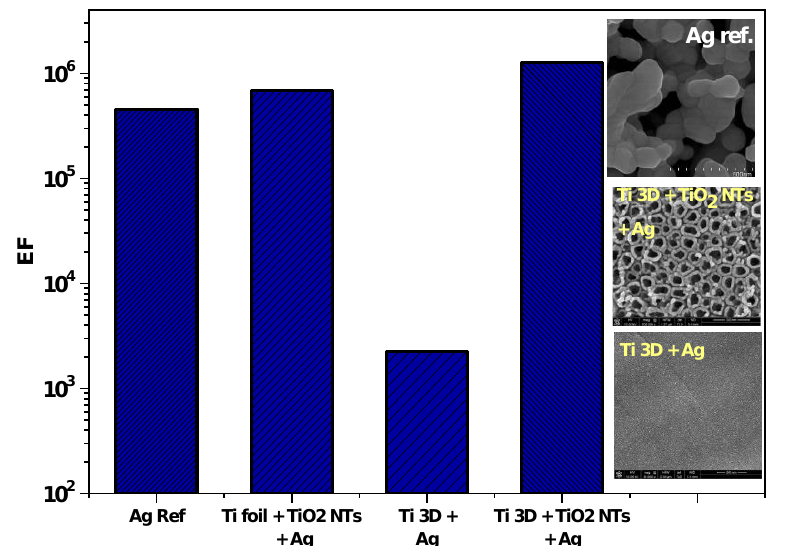
Figure 11. Comparison of the estimated E F from adsorbed pyridine (0.05 M + 0.1 M KCl) on the fabricated platforms in this work with TiO 2 nanotube-based substrates formed on a Ti foil with a silver deposit. An electrochemically roughened silver electrode was used as a reference. Illustrative SEM images for the discussed samples are attached to the Figure.